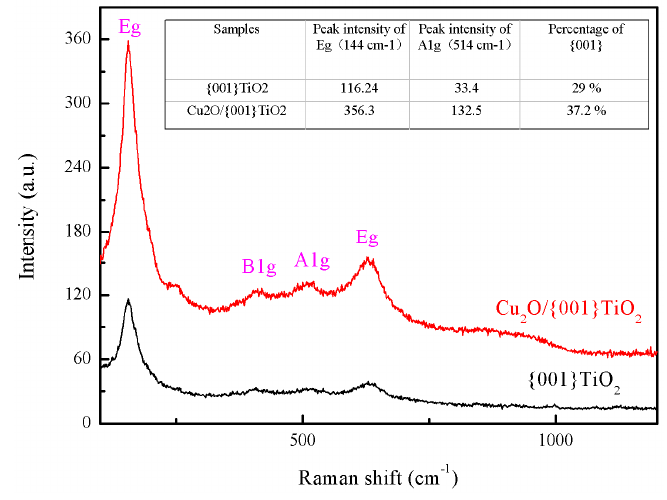
Figure 4. Raman spectrum of the catalysts.